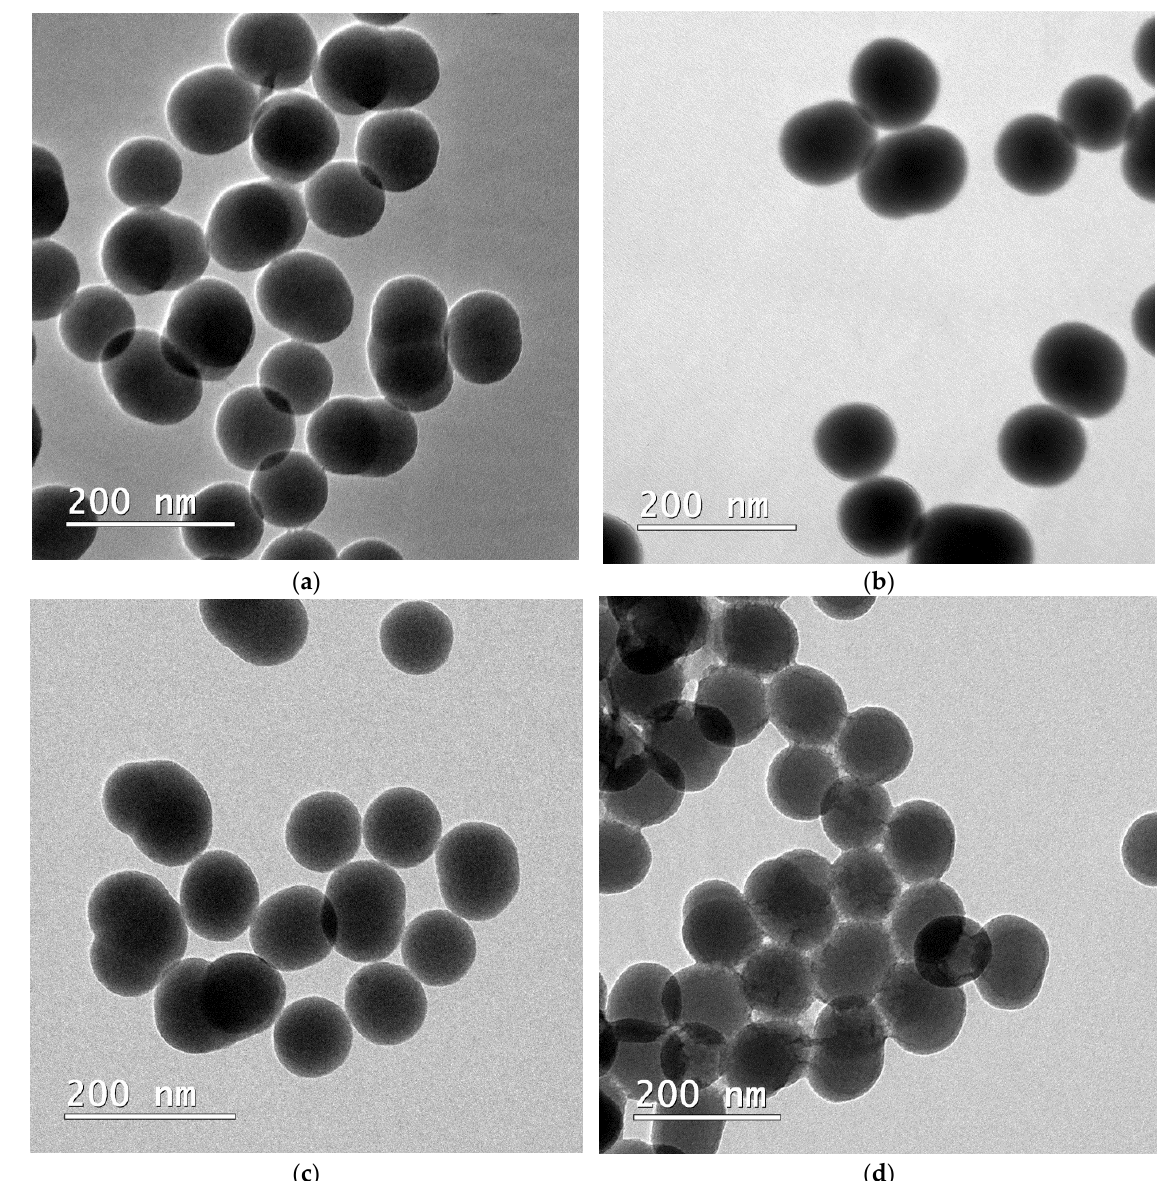
Figure 2. TEM image of silica and organically modified silica SiO 2 -1 ( a ), SiO 2 -1-Org1 ( b ), SiO 2 -1-Org2 ( c ), and SiO 2 -1-Org3 ( d ).